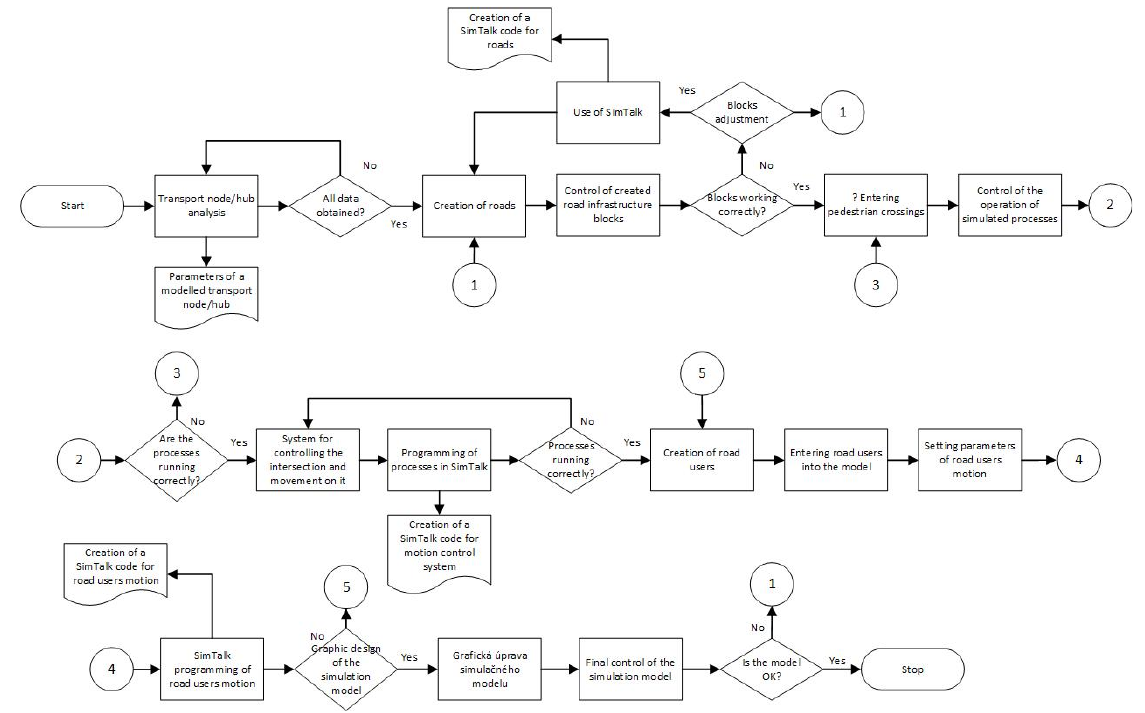
Figure 2. Draft methodology for creation of traffic processes simulation and visualization by Tecno- matix Plant Simulation.